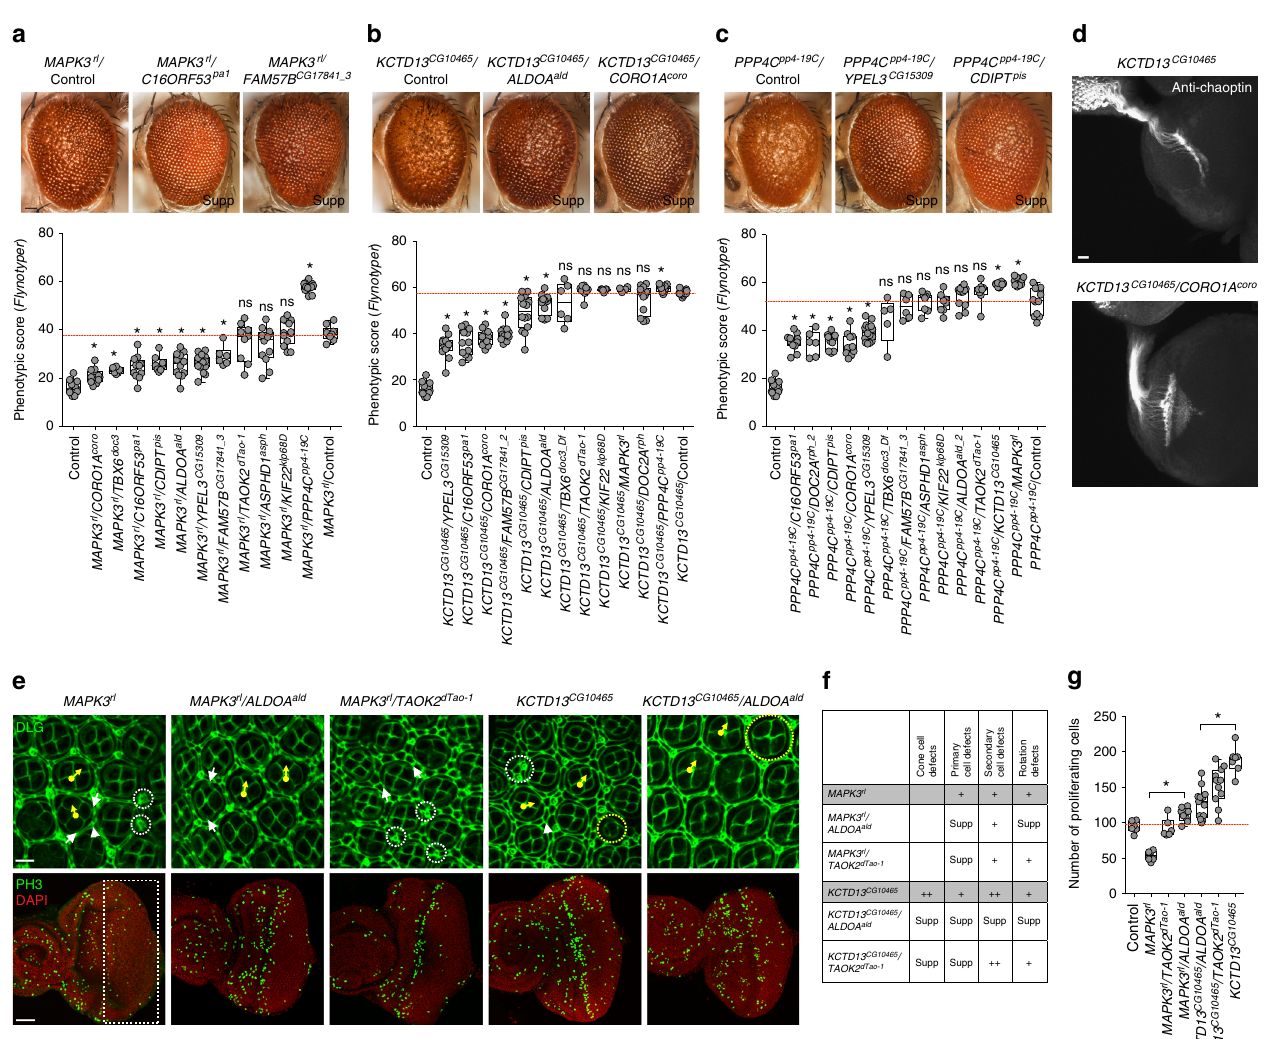
Fig. 6 Phenotypic and functional effects of pairwise knockdown of 16p11.2 homologs. Representative bright fi eld adult eye images (scale bar = 50 µ m) and box plots of Flynotyper scores of pairwise knockdown of a MAPK3 rl with other 16p11.2 homologs ( n = 6 – 15, * p < 0.05, Mann – Whitney test), b KCTD13 CG10465 with other 16p11.2 homologs ( n = 4 – 14, * p < 0.05, Mann – Whitney test) and c PPP4C pp4-19C with other 16p11.2 homologs ( n = 5 – 17,